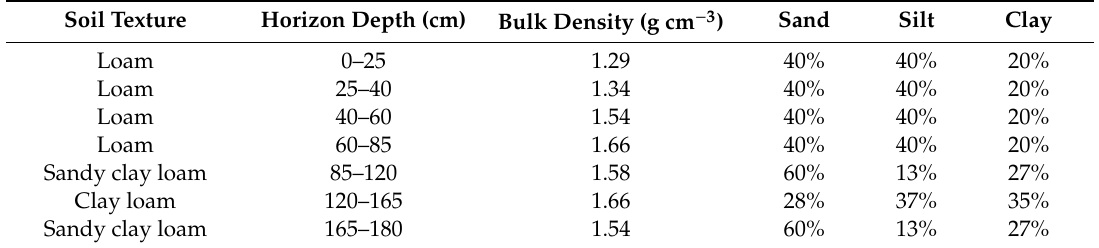
Table 1. The soil texture characteristics at the experimental site in the North China